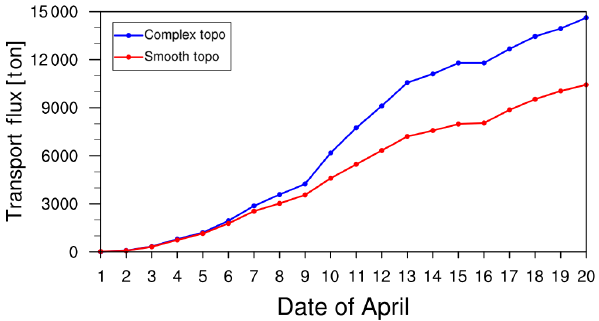
Figure 14. Accumulated integrated total transport flux of BC across the Himalayas estimated from the simulations with the complex and smooth topographies during 1–20 April